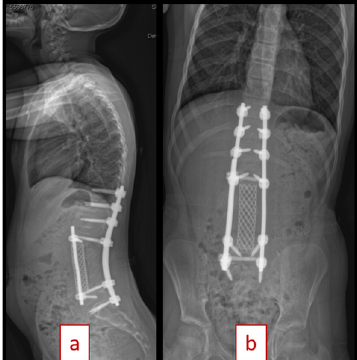
Figure 4. (a) Spine PA view fi ve-month postoperative